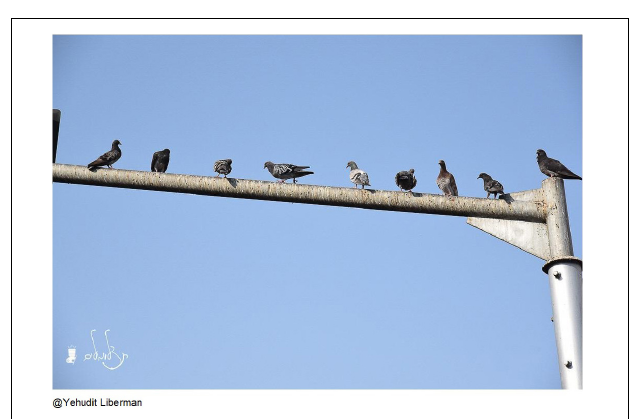
FIGURE 11 | Noah’s chosen photograph